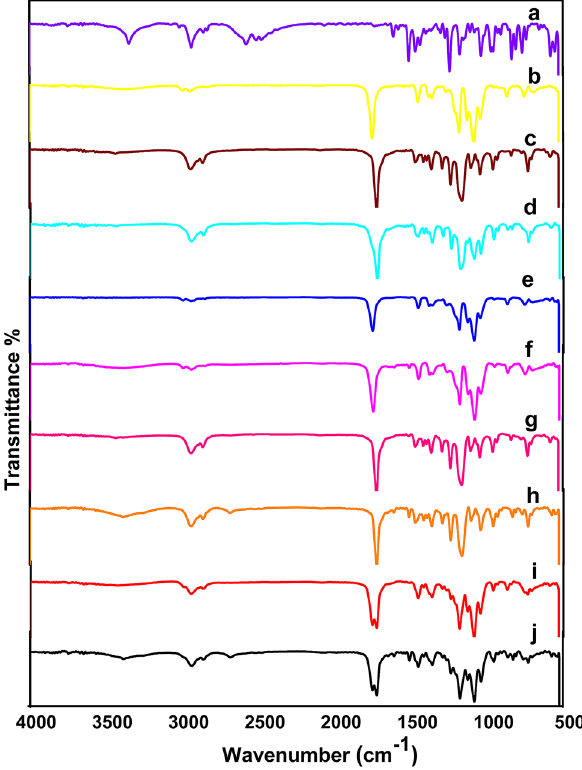
Figure 2. ATR-FTIR spectra of ( a ) VEN, ( b ) PLA cast film, ( c ) PCL cast film, ( d ) PLA/PCL blend cast film, ( e ) 10% PLA NFs (Plain), ( f ) VEN-10%PLA NFs (Medicated), ( g ) 14% PCL NFs (Plain) ( h ) VEN-14% PCL NFs (Medicated), ( i ) 10% PLA/PCL composite NFs (Plain), and ( j ) VEN-10%PLA/PCL composite NFs